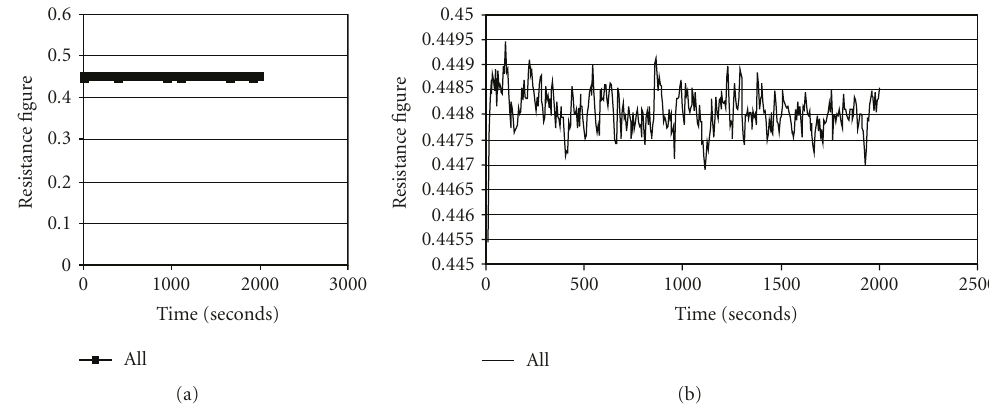
Figure 3: The RESISTOR curve for CRATER with all rating factors, that is, FHI, SHI, and neutral behavior: (a) compressed scale, (b) detailed